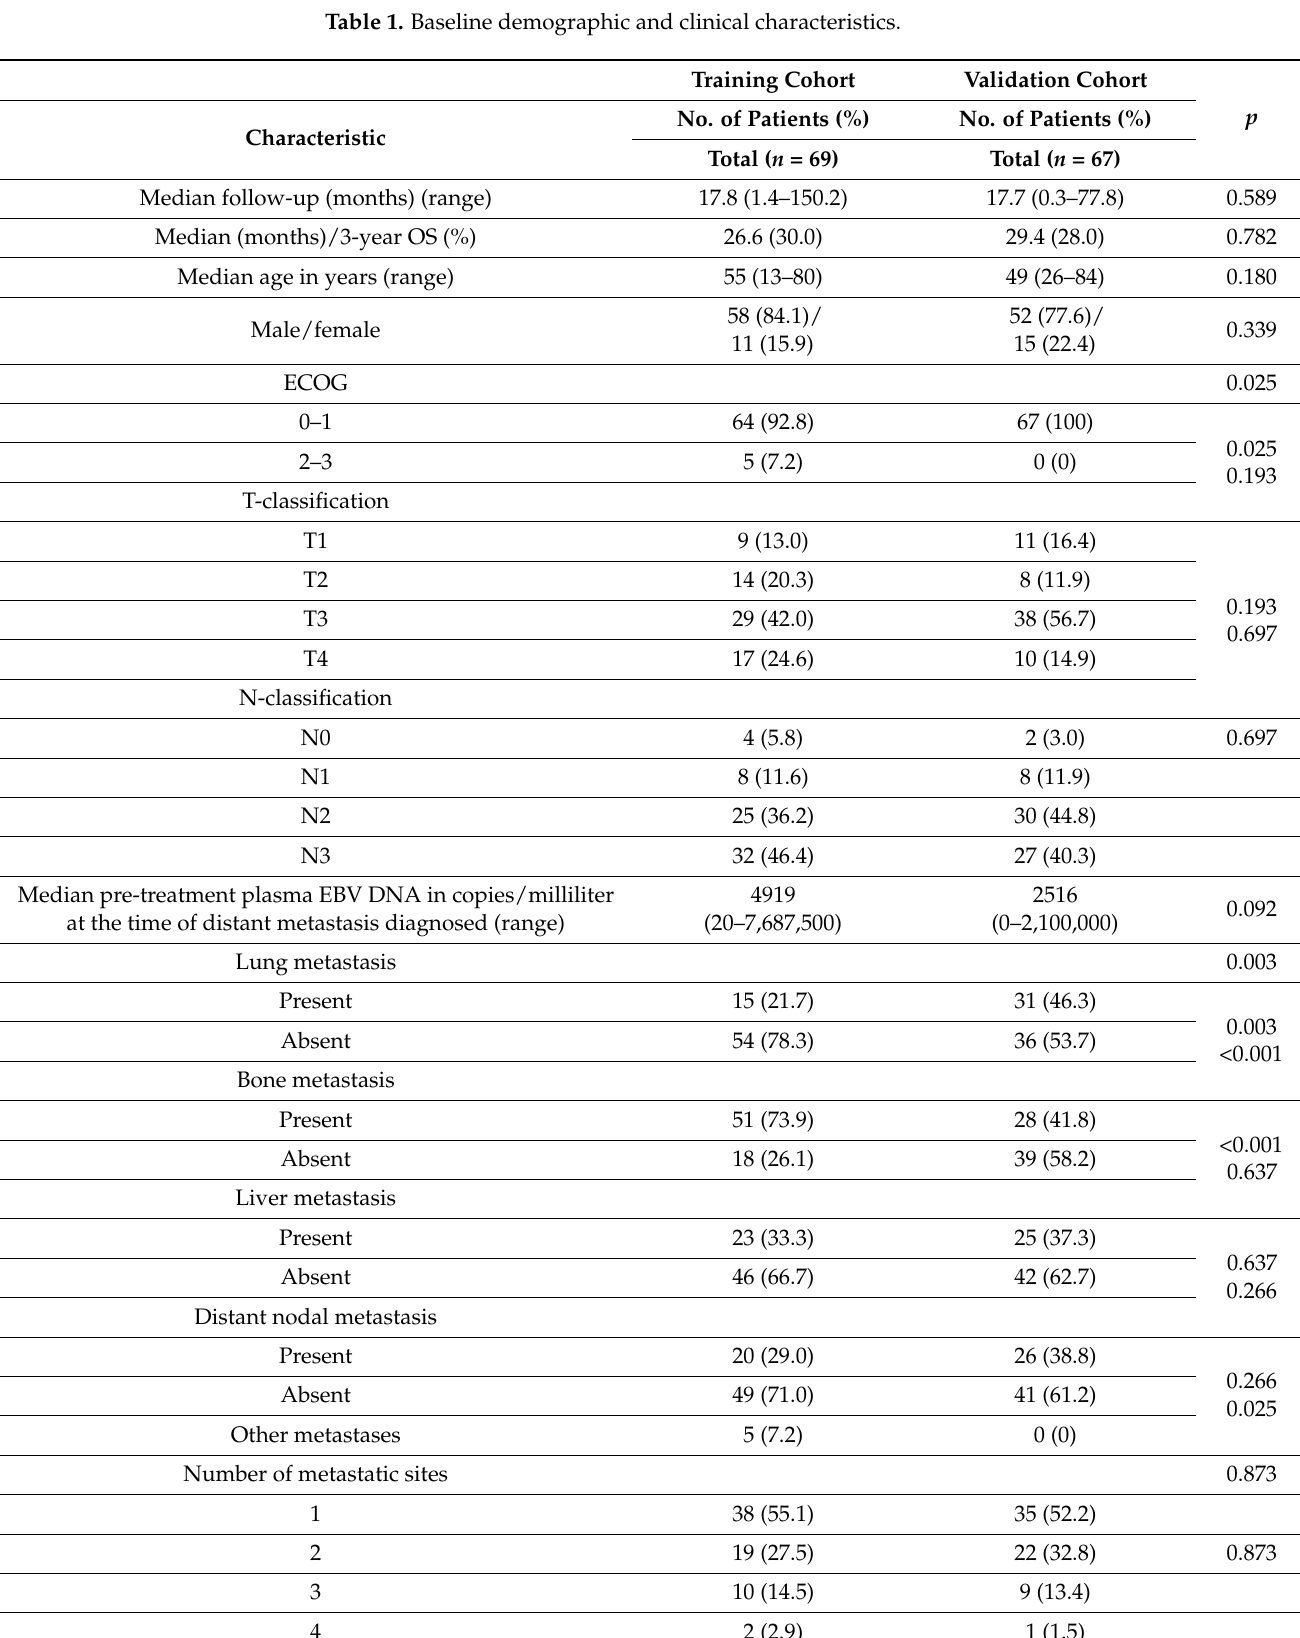
Table 1. Baseline demographic and clinical